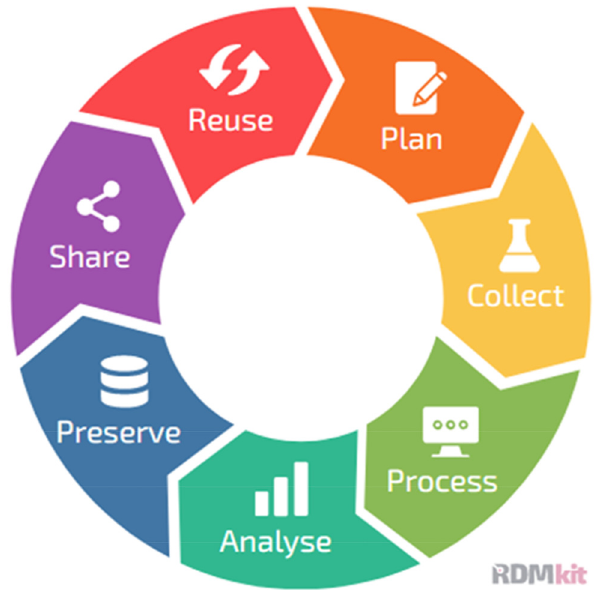
Figure 1: Taken from ELIXIR (2021) research data